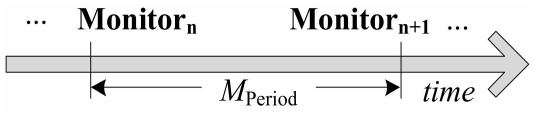
Figure 3. Monitoring Period M Period for